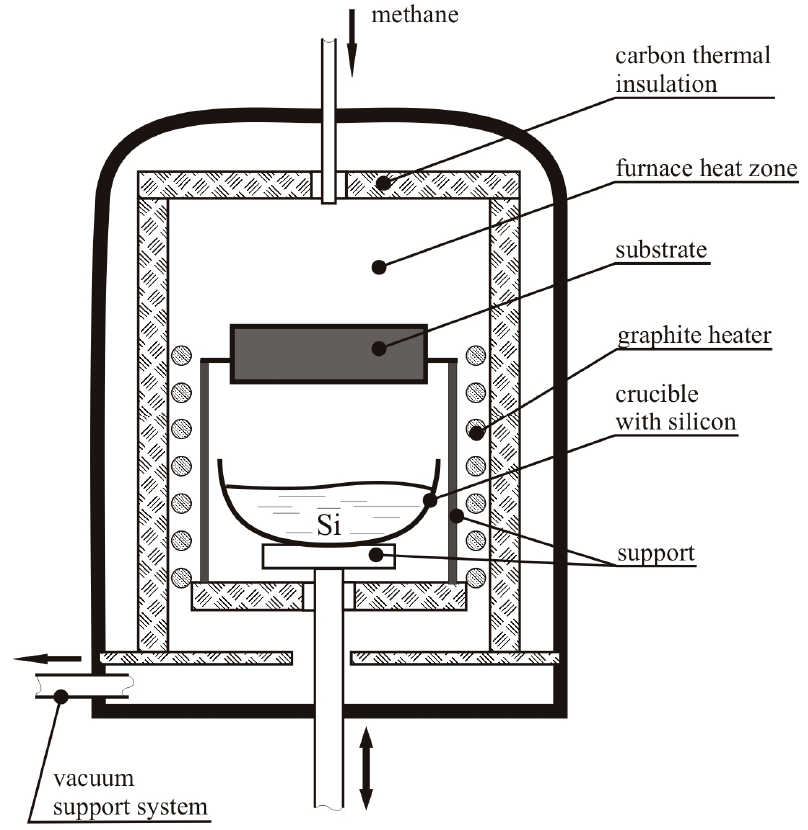
Figure 1. The layout of the reactor for deposition of gas-tight SiC coatings.